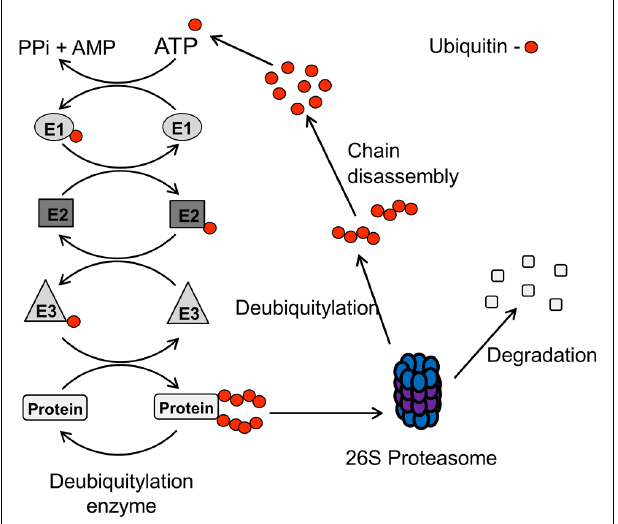
FIGURE 2 | Schematic of the UPP pathway. The UPP pathway is initiated by an E1 activating enzyme in an ATP-dependant process which forms a thioester with the ubiquitin molecule.The activated ubiquitin molecule is then transferred to a ubiquitin conjugating enzyme (E2), and the E2-ubiquitin complex then binds with an E3 ubiquitin ligase and the target protein.The E3 ubiquitin ligase transfers the ubiquitin moiety onto specific lysine residues within the target protein, and the formation of ubiquitin chains through internal lysine residues within the ubiquitin protein (termed polyubiquitylation), usually targets the protein for degradation by the 26S proteasome. Protein degradation is achieved by deubiquitylation, and subsequent disassembly, of the ubiquitin chains from the ubiquitylated protein which is then degraded, and the ubiquitin protein is